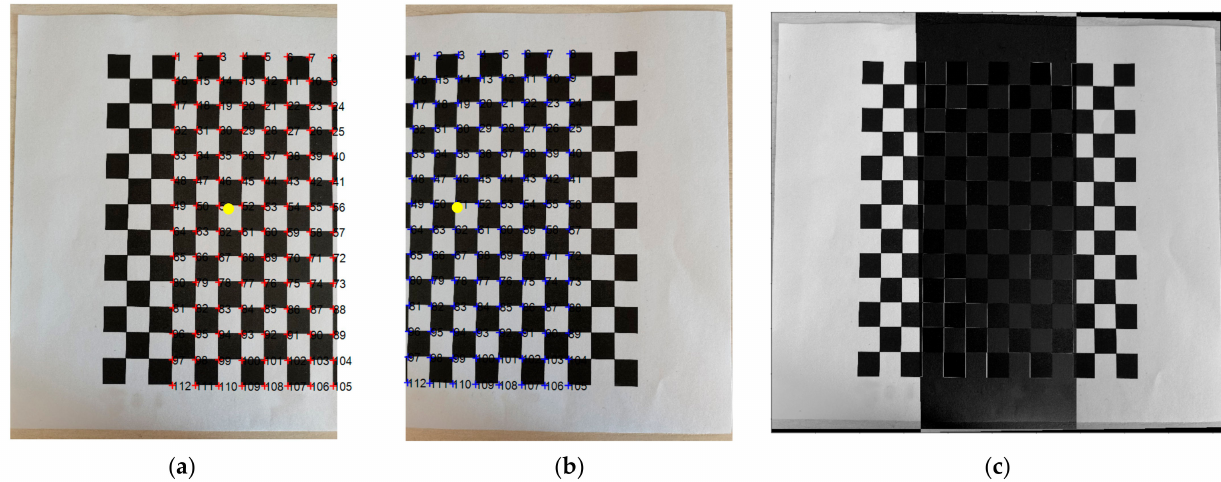
Figure 3. Primary data of the simulation scene. ( a ) Left image and the feature points. ( b ) Right image and the feature points. The symbols + with the same number in ( a , b ) are a pair of known matching points. The yellow dots are the center points of the overlapping region of the left and right images. ( c ) Registered